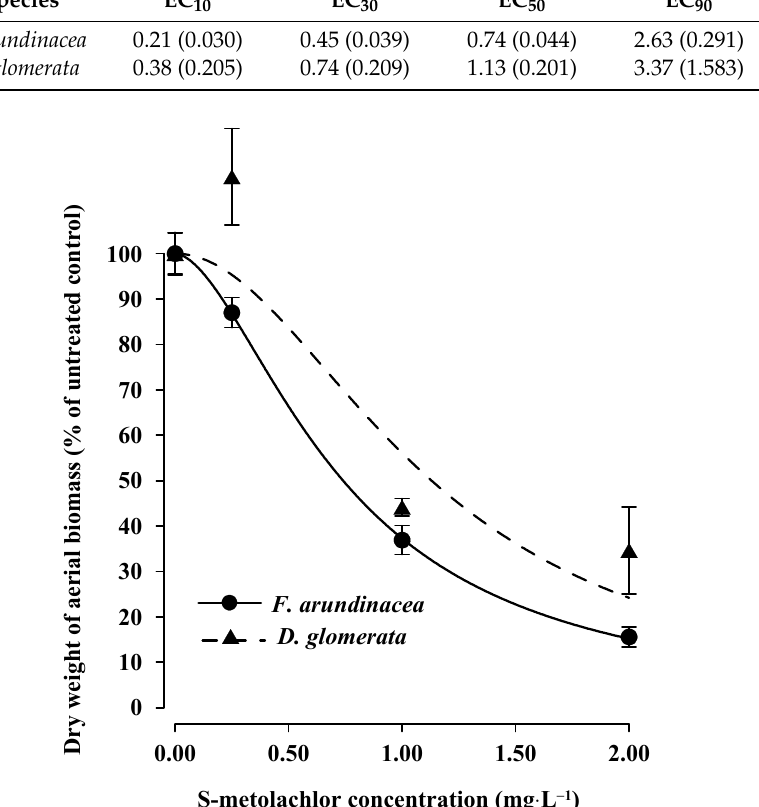
Figure 2. Effects of S-metolachlor (SMR) concentrations on regrowth of dry weight aerial biomass of F. arundinacea (tall fescue) and D. glomerata (orchardgrass) at 87 DAT (after the mowing of aerial biomass at 36 DAT). The symbols indicate the observed data, the lines show the fitted curves according to a logistic dose–response model (estimated effective concentrations are reported in Table 1). Vertical bars represent ± standard error.